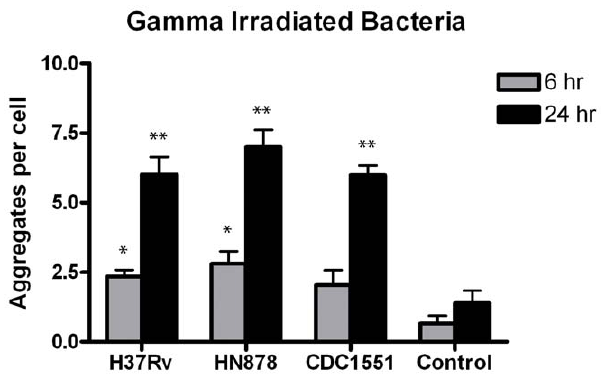
Figure 4. Addition of gamma-irradiated Mtb strains produces low level A549 cell LR aggregation. Gamma-irradiated CDC1551, HN878 and H37Rv bacilli were added to monolayers at an inoculum of 100 bacilli per host cell. The cells were then processed for confocal microscopy and LR aggregation defined by CT-B staining and quantified as described. Controls without bacilli produced LR aggregation at 6 and 24 hr post-treatment comparable to controls for other previous experiments. At 6 hr post-treatment a significant increase in LR aggregation was observed with strains H37Rv and HN878 compared to controls (*p-value , 0.001). LR aggregation with all three strains at 24 hr post-treatment was significantly increased compared to controls (**p-value , 0.001). Experiments were performed in triplicate and repeated three times. A total of 15 fields were imaged per coverslip, incorporating approximately 30–50 host cells per field. Data presented are the average of three experiments. Images were captured at 63x magnification.